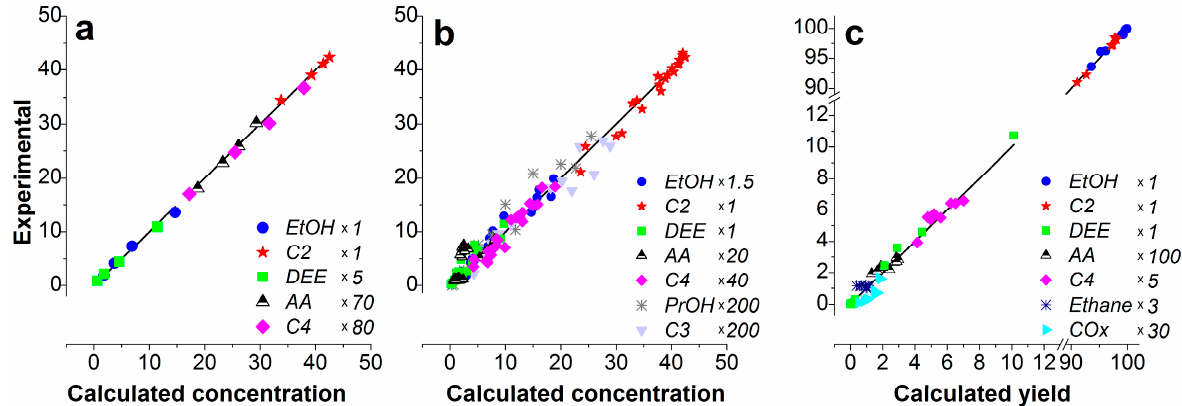
Figure 3. Correlation between the measured and calculated values. Reactor design: plug-flow ( a , b ), tubular with wall heating ( c ). Ethanol: pure ( a , c ), contaminated ( b ). In the legend, the numbers mean the scaling factors for each substance. Table 2. Calculation